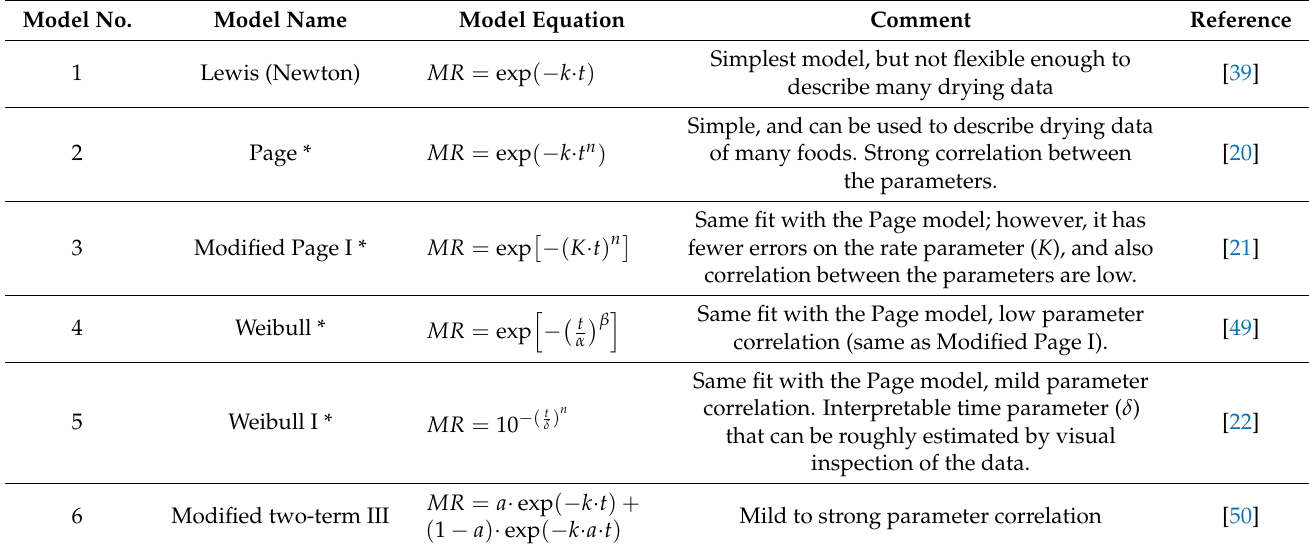
Table 6. Suggested thin-layer drying models.